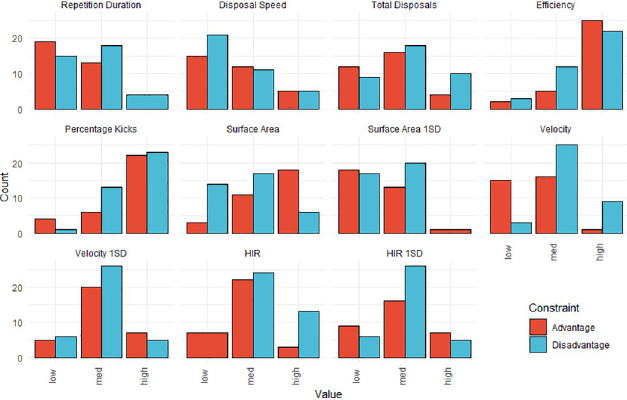
Fig 3. Results of the discretisation of each behaviour metric. Repetition counts for each category are displayed for the advantage (red) and disadvantage (blue) constraint conditions.